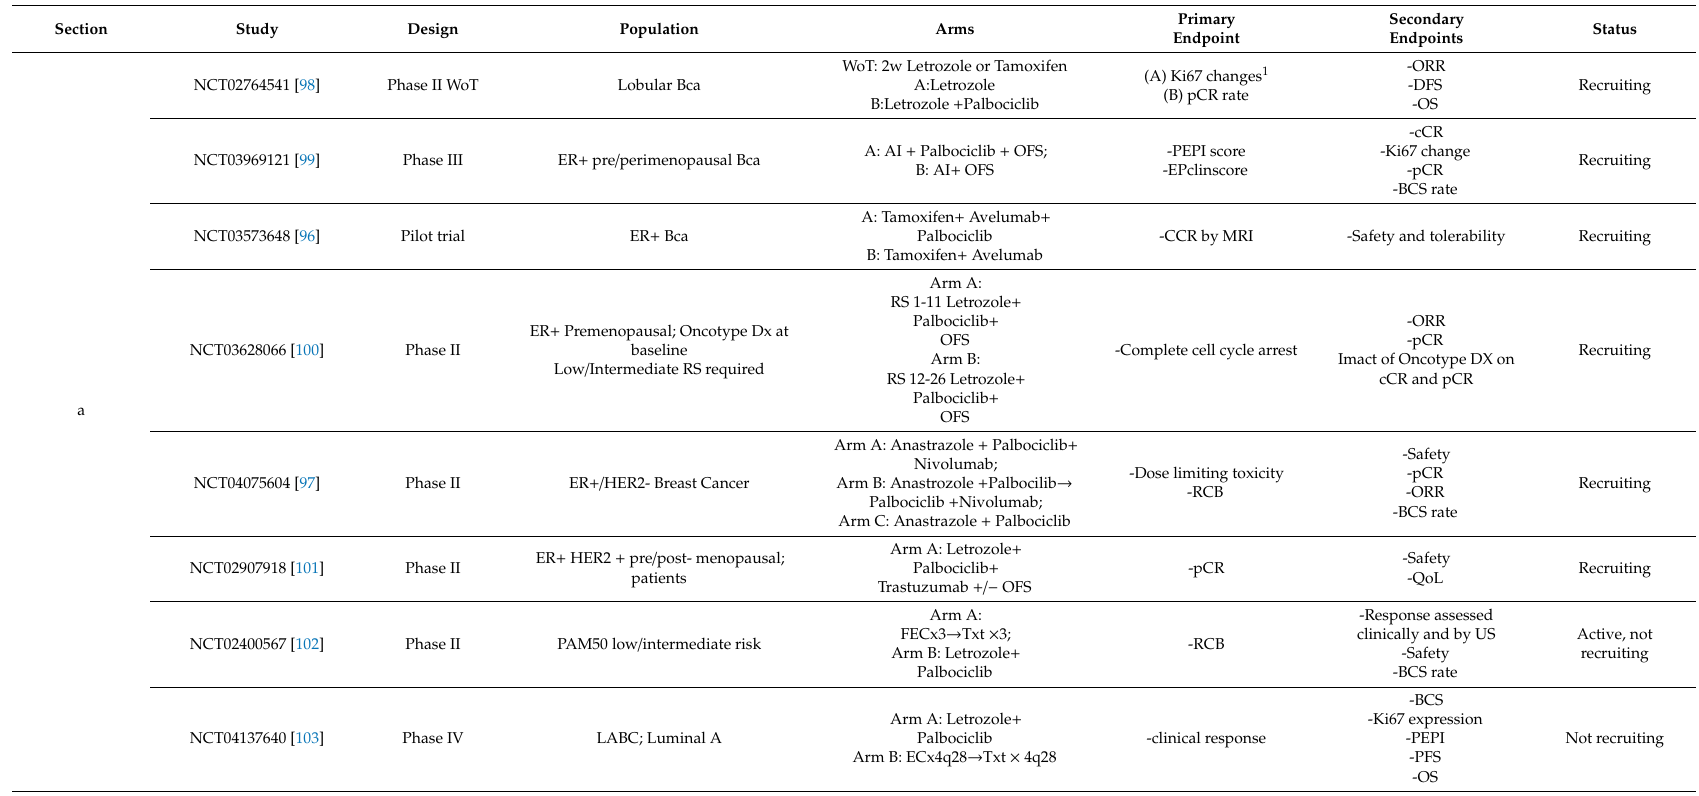
Table 3. a: ongoing trial with Palbociclib in the neoadjuvant setting. b: ongoing trials with Ribociclib in the neoadjuvant setting. c: Ongoing trials with Abemaciclib in the neoadjuvant